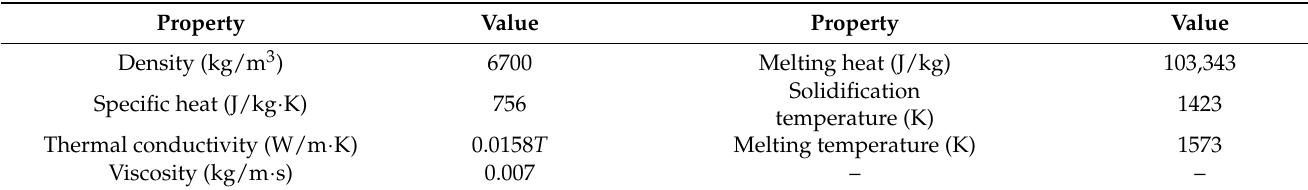
Table 2. Physical properties of hot iron.